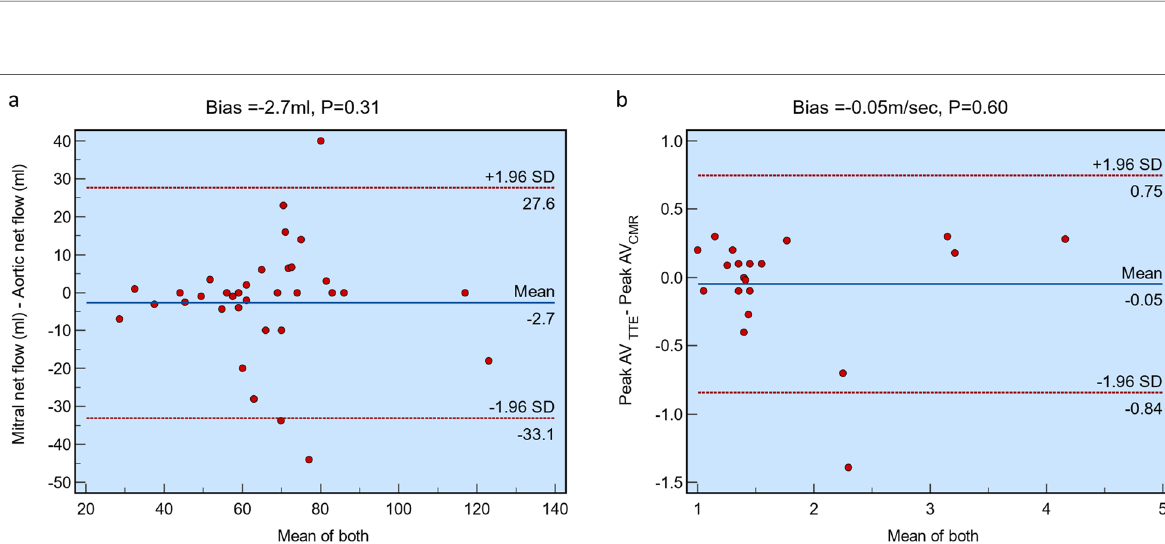
Fig. 4 Bland‑Altman plots demonstrating no significant bias between each